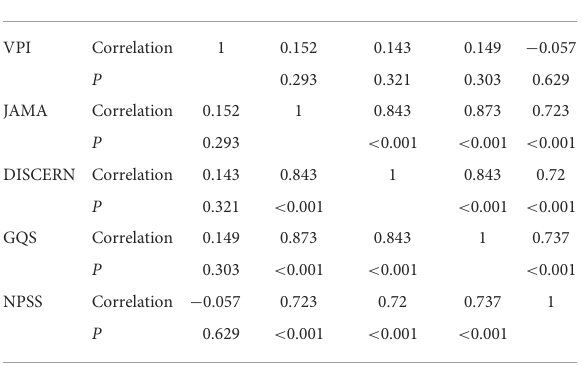
TABLE 6 Spearman correlation analysis was applied to assess the correlation between JAMA, GQS, DISCERN, NPSS, and